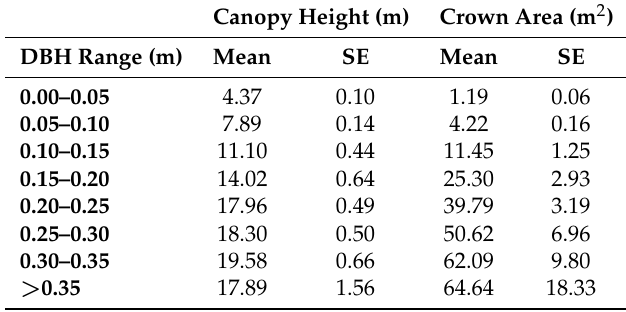
Figure 8. TLS derived crown area for a given DBH; ribbon showing 95% confidence interval. The spread of crown sizes increases with increasing DBH ( n = 807). Table 1. Variability in tree crown structural parameters as a function of DBH class, showing values of the mean and standard error of the